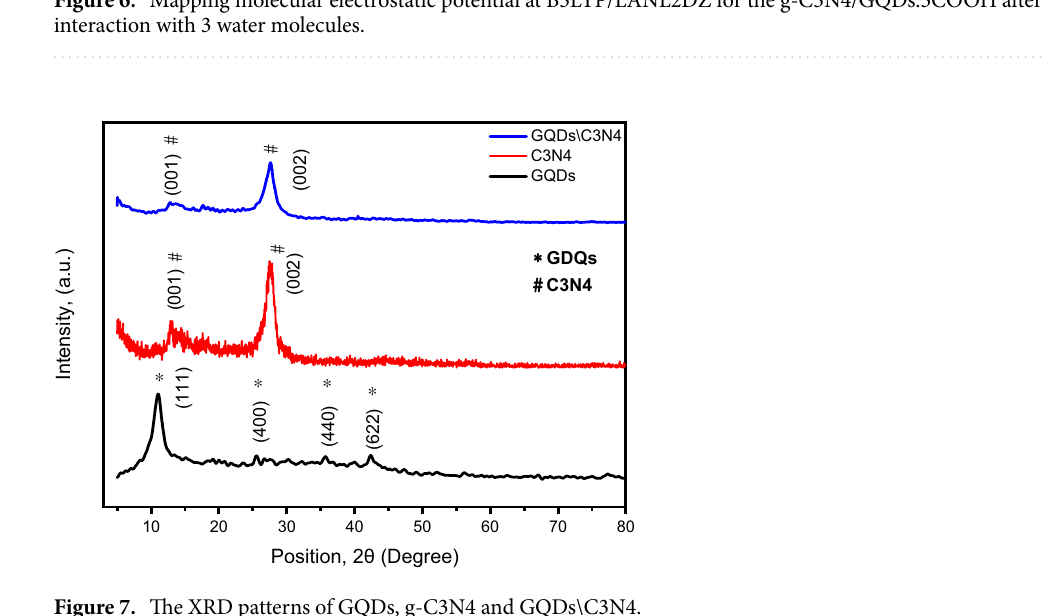
Figure 7. The XRD patterns of GQDs, g-C3N4 and